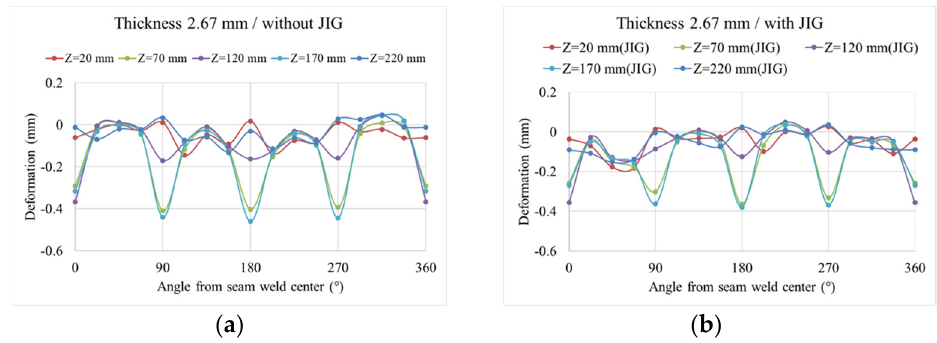
Figure 16. Weld deformation in the radial direction according to the circumferential direction at thickness 2 mm: ( a ) without jig; ( b ) with jig.